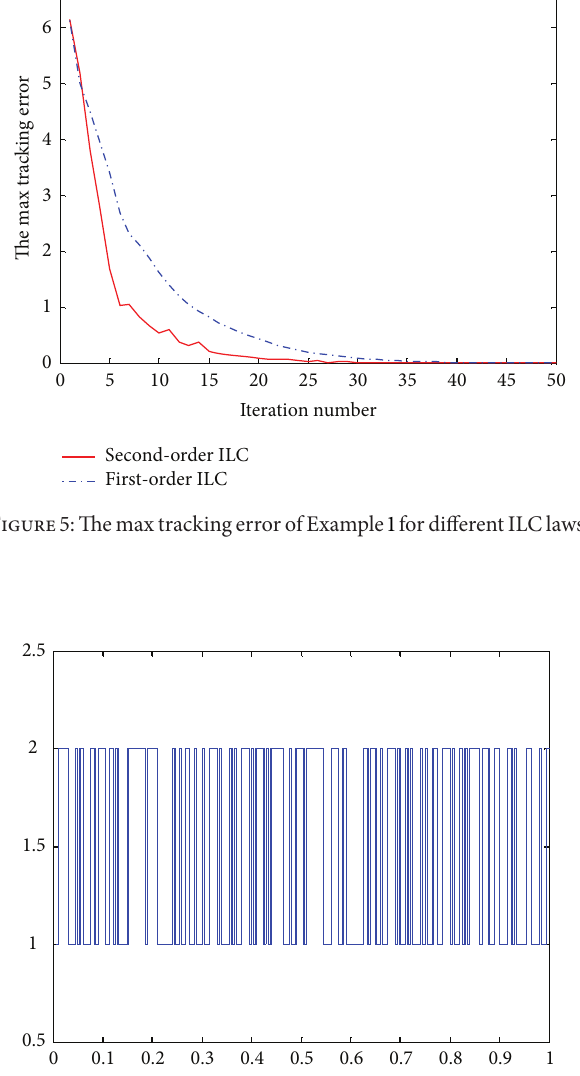
switched rule on the time domain, the arbitrary switched